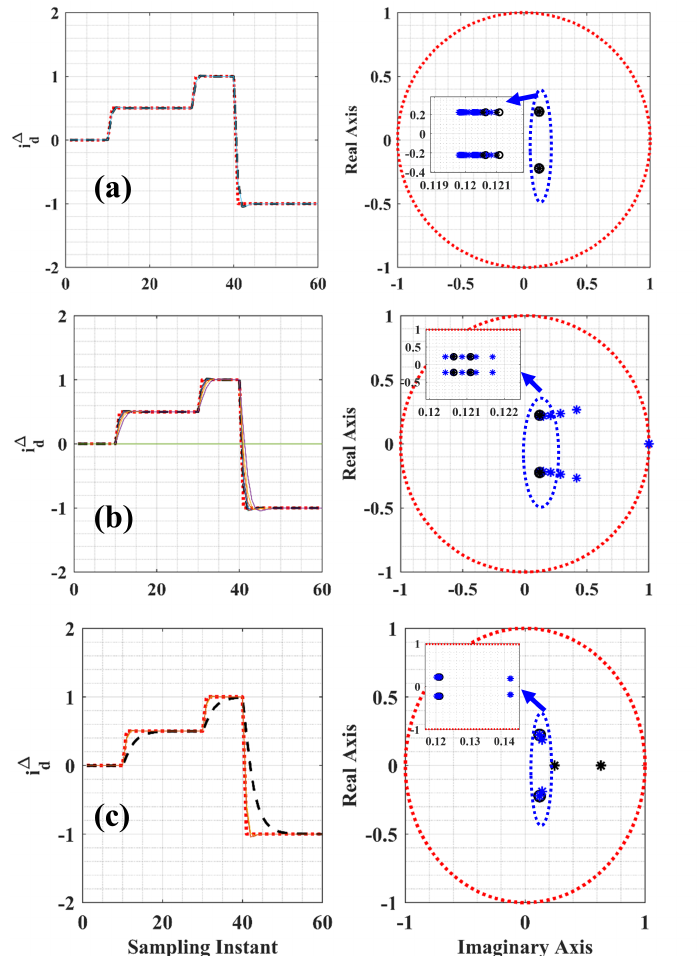
Figure 18. Effect of: ( a ) N p with a = [ 0.237, 0.237 ] , N = [ 4, 4 ] ; ( b ) a with N p = 4, N = [ 4, 4 ] ; and ( c ) N with a = [ 0.237, 0.237 ] , N p = 4 on the dynamic response and